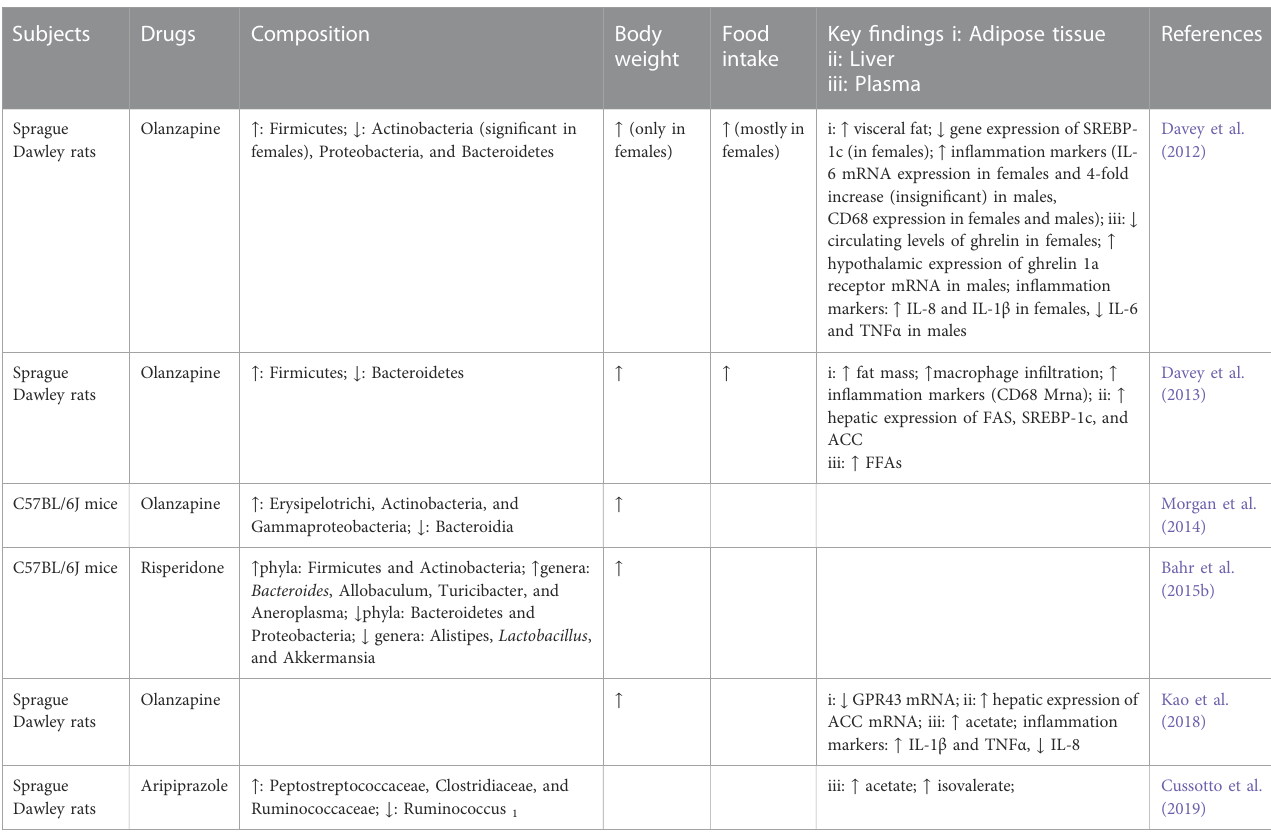
TABLE 1 Studies of SGAs and microbiota in